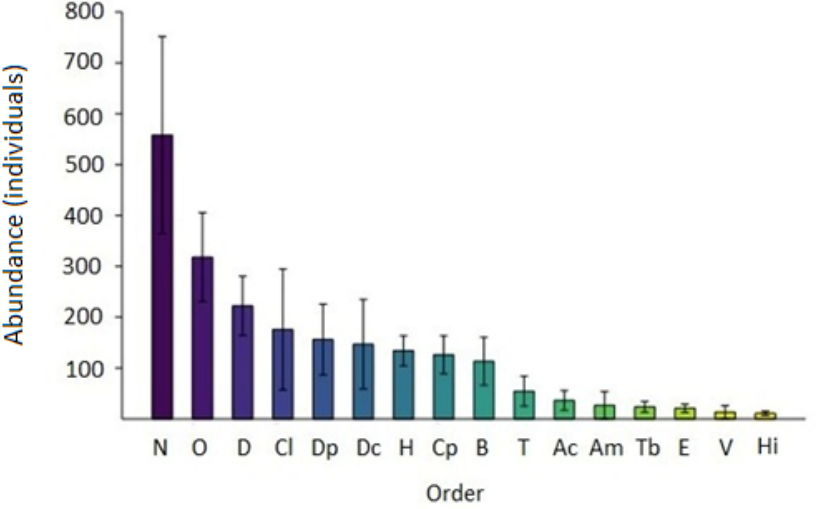
Fig. 3: Macroinvertebrate order abundances. Orders with abundances below 1% were excluded. Bars represent standard error. N: Neotaenioglossa (Mollusca: Gastropoda). O: Odonata (Arthropoda: Insecta). D: Diptera (Arthropoda: Insecta). Cl: Calanoida (Arthropoda: Maxillopoda). Dp: Diplostraca (Arthropoda: